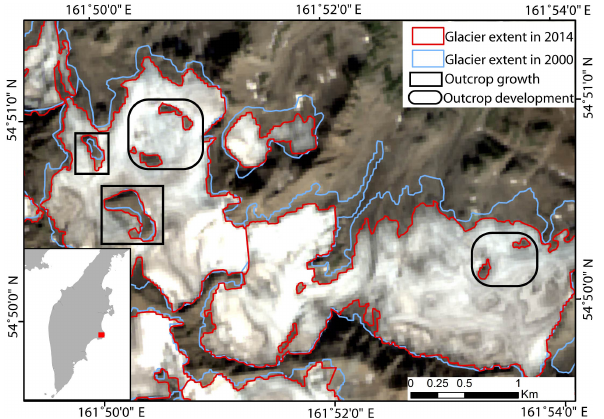
Figure 5. Examples of glaciers on the Kronotsky Peninsula mapped in 2000 and 2014 (Landsat 2014 background image), revealing sta- tionary thinning and a notable decline in glacier surface